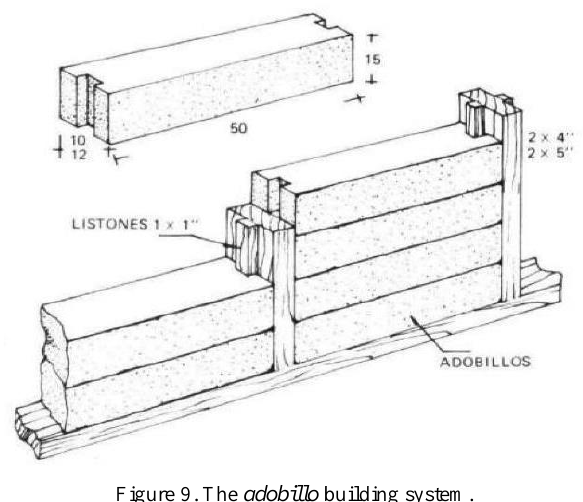
Figure 9. The adobillo building system.